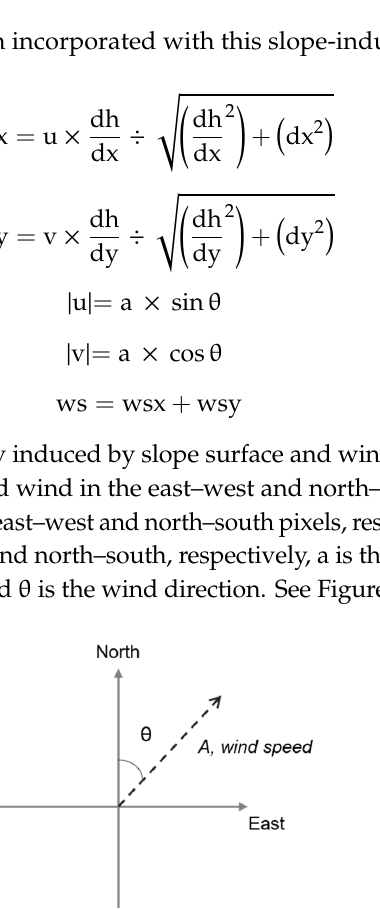
Figure 6. Kernel used to compute the vertical velocity.